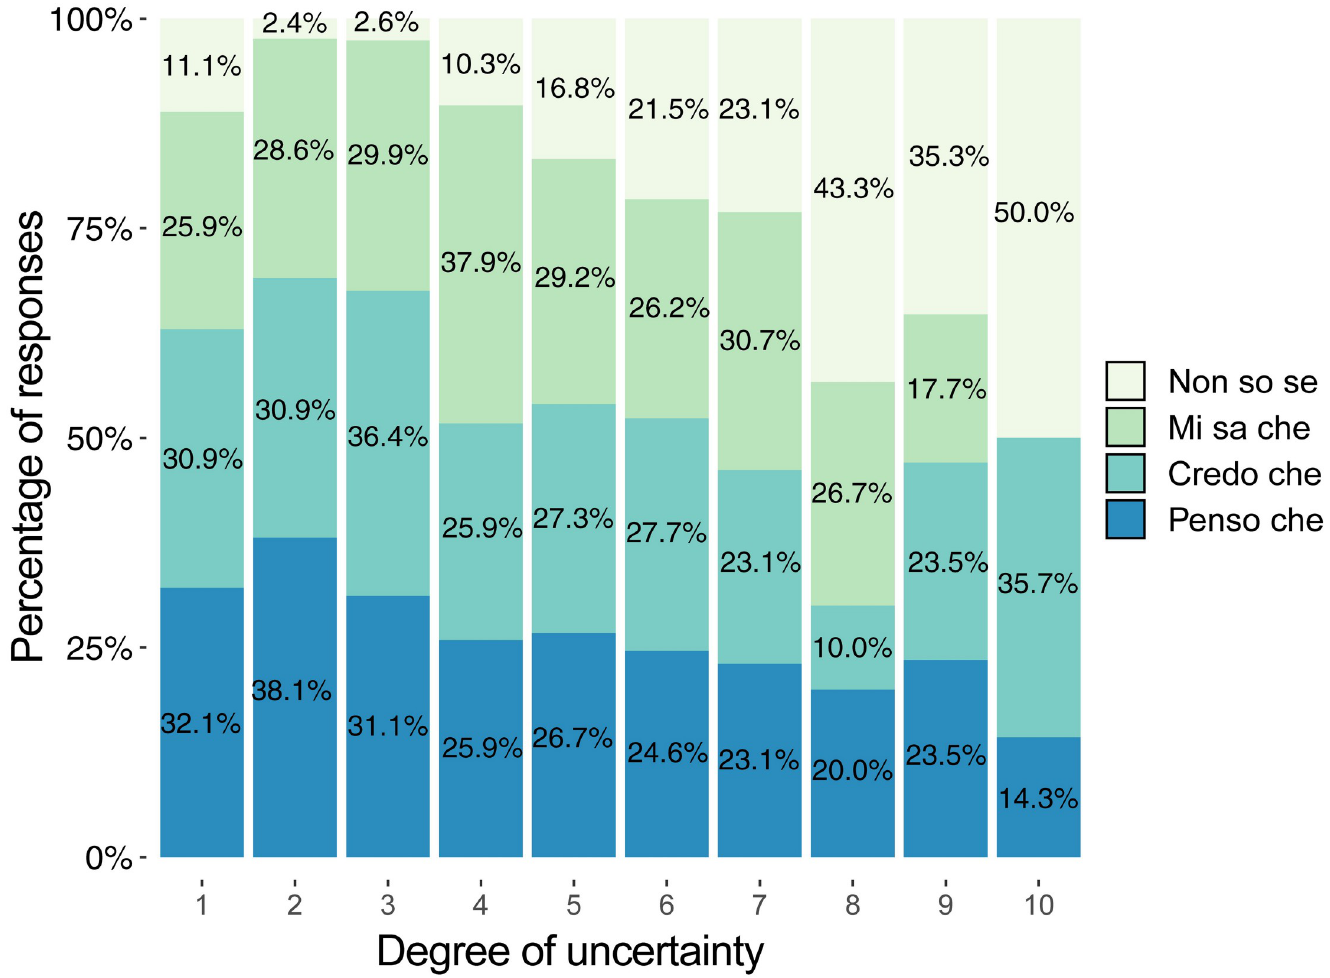
Fig 8. Degrees of uncertainty assigned to the sentences (3) Non so se p, (4) Mi sa che p, (5) Credo che p, (6) Penso che p. � For each degree of uncertainty (for each column) the percentage of Non so se , Mi sa che , Credo che and Penso che answers given by the experimental subjects is